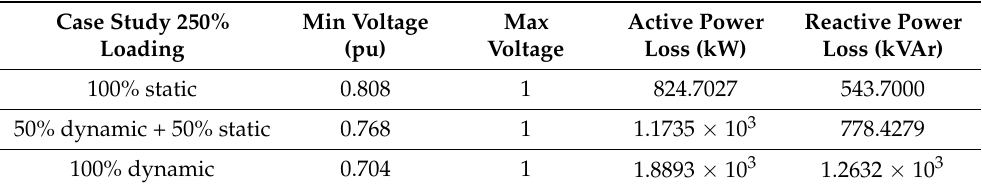
Table 4. Comparison between static and dynamic loads at 250% loading, i.e., a total load of (8950 + j4362)